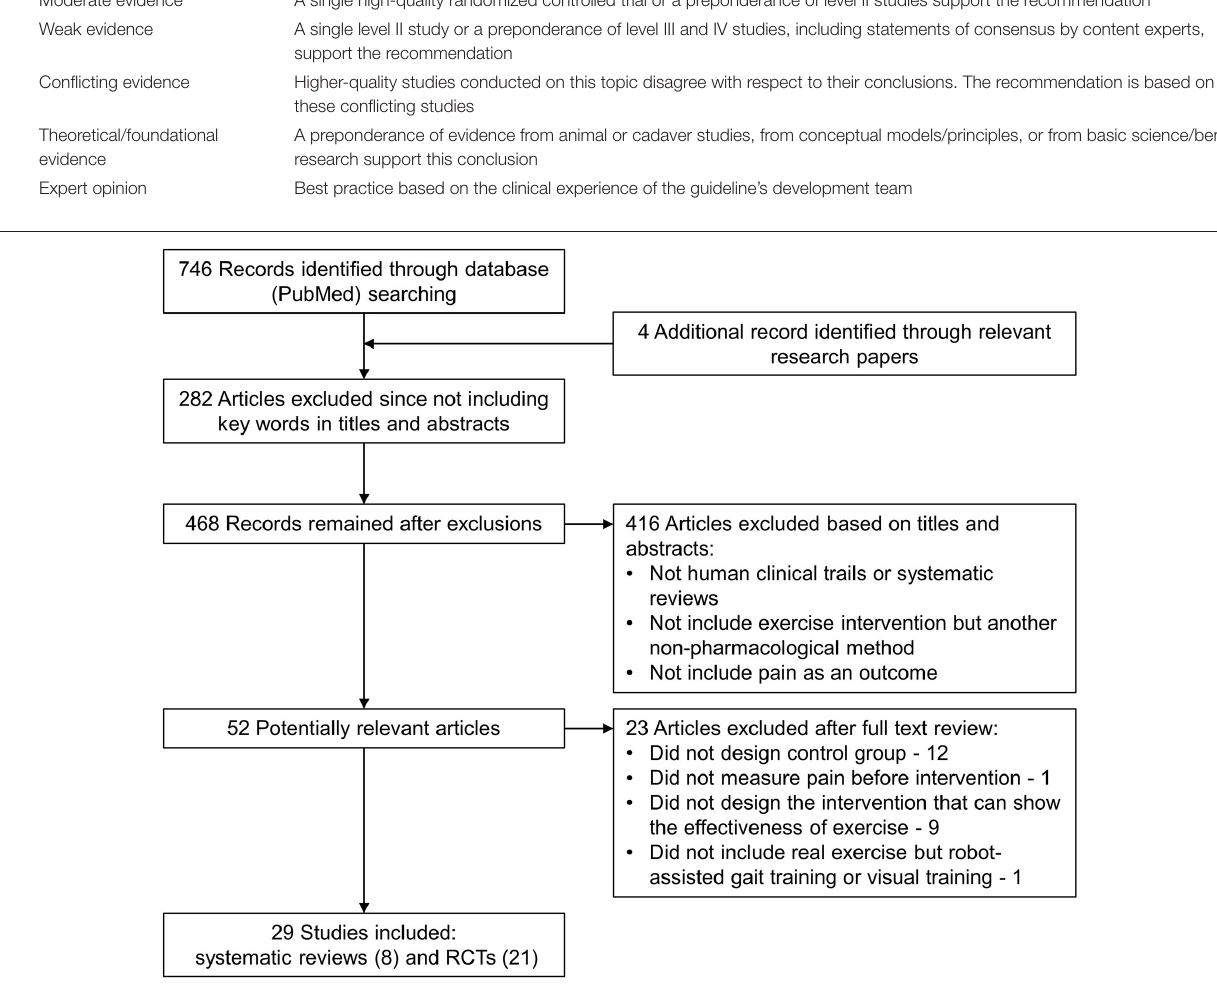
FIGURE 1 | Study flow